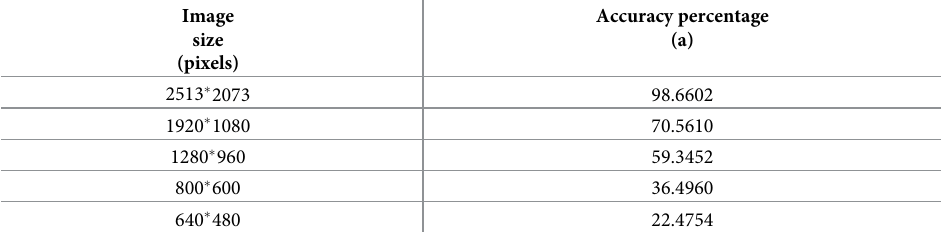
Table 2. Segmentation results considering different image